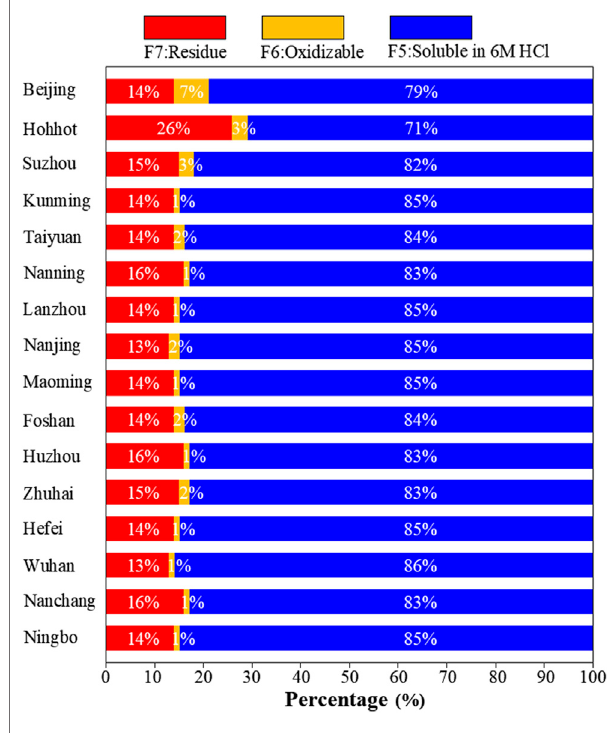
sequential chemical extraction of sewage sludge